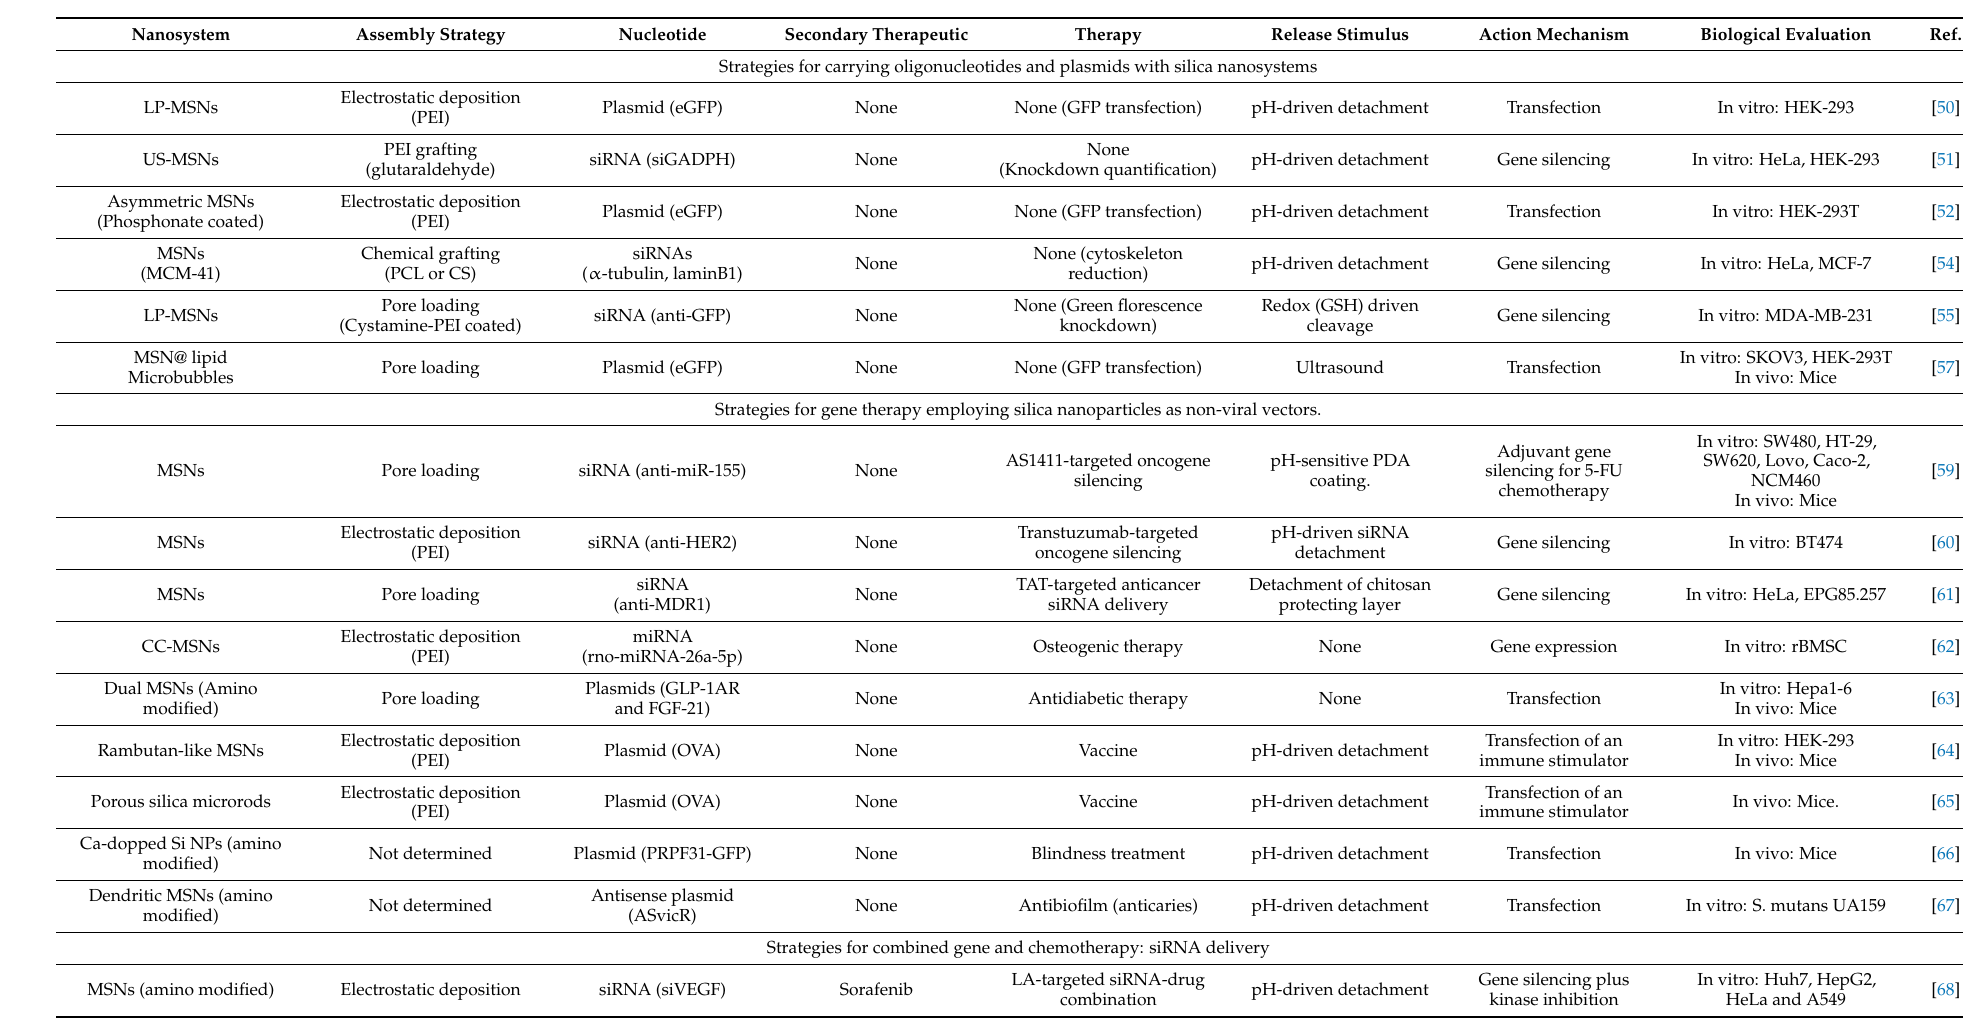
Table 1. Reported devices based on the combination of silica nanoparticles and